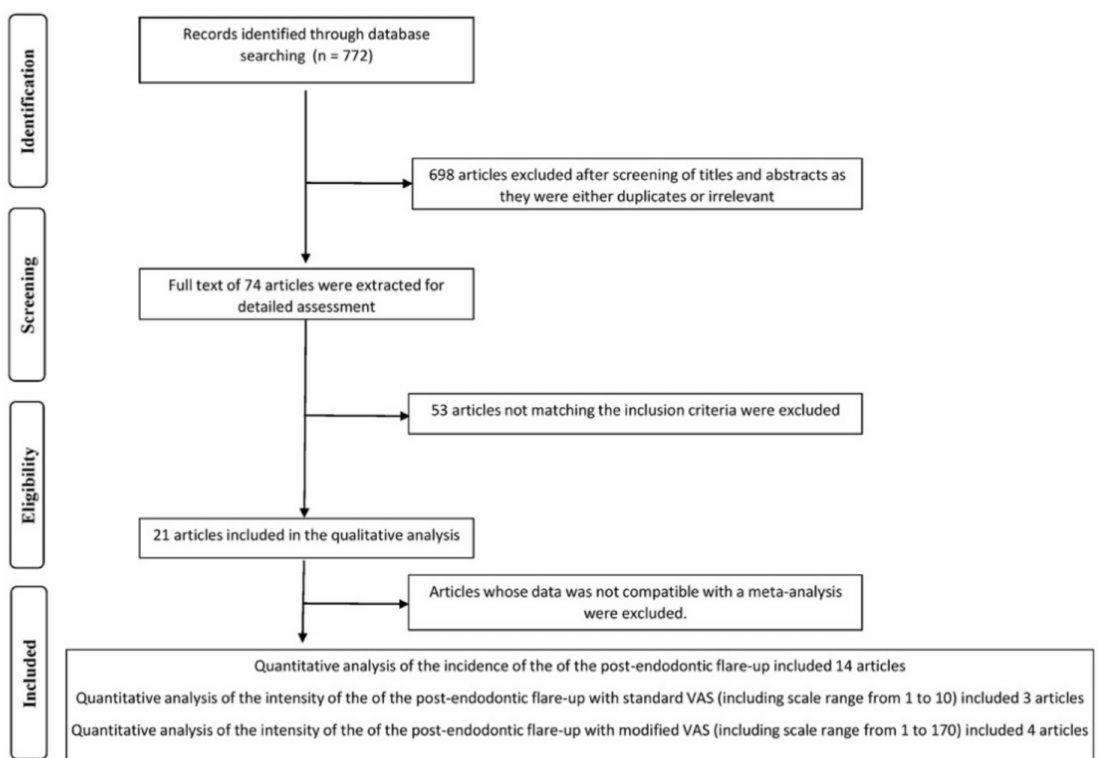
Figure 1. PRISMA flowchart summarizing the selection process employed in the